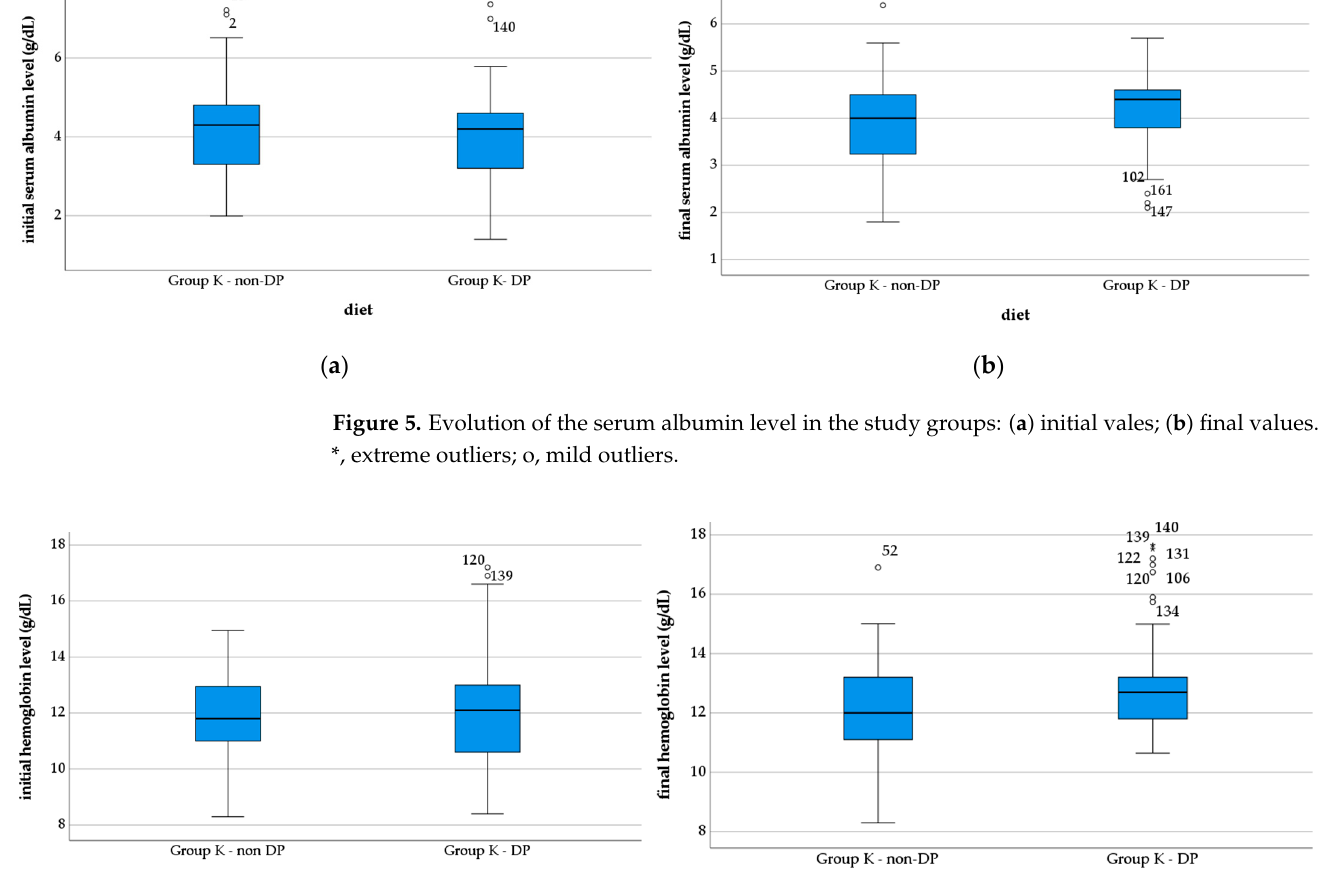
Figure 5. Evolution of the serum albumin level in the study groups: ( a ) initial vales; ( b ) final val- ues. *, extreme outliers; o, mild outliers.